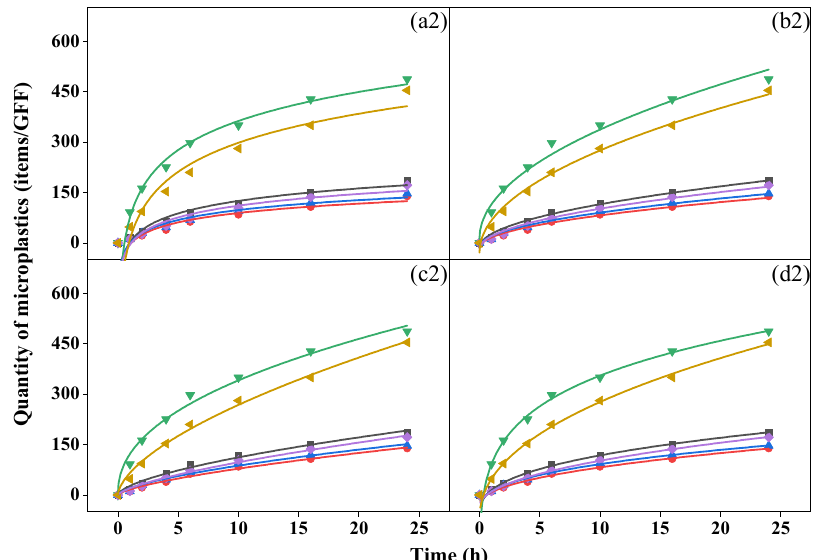
Figure 3. Fit curves of microplastics over time from ( a ) Elovich equation, ( b ) Parabolic diffusion equation, ( c ) Power function equation, and ( d ) modified Freundlich equation of activated-carbon mask sample (AC), N95 mask sample (N95), surgical mask sample (SU), cotton mask sample (CO), fashion mask sample (FA), and blank (AIR) in indoor ( top , ( a1 – d1 )) and outdoor ( bottom , ( a2 – d2 )) conditions.